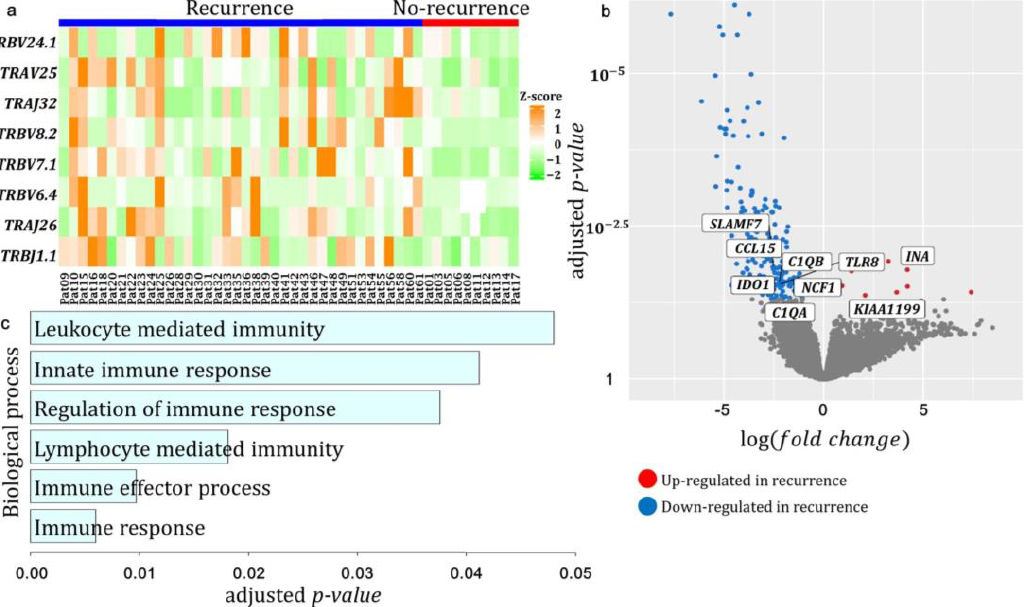
Figure 3. Genes correlated with specific TCRs and their enriched biological process. ( a ) Expression of eight TCR segment genes differentially expressed in recurred patients; ( b ) A volcano plot for differentially expressed genes (DEGs) between the recurrence and no recurrence groups. Fold change was calculated by dividing the recurrence group’s average expression by that of no recurrence group; ( c ) GO biological process terms that were significantly enriched in both DEGs and genes having negative correlation with those eight TCRs.